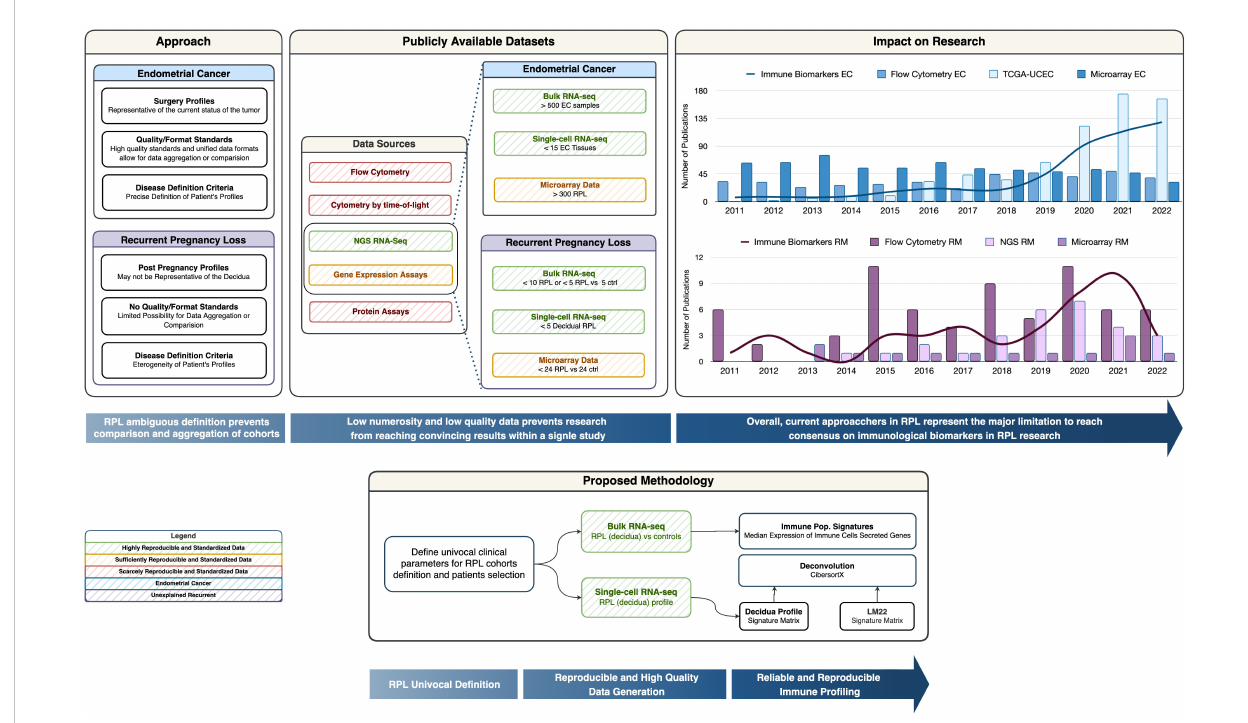
FIGURE 1 Graphical Abstract. The Approach box provides a summary of Recurrent Pregnancy Loss de fi nition pitfalls compared to Endometrial Cancer Research. The Publicly available datasets box provides insight into the reproducible and non-reproducible technologies in the immunological fi eld, along with a representation of the numerosity for the cohorts in RPL vs . EC. The Impact on Research box represents the trend of publication on PubMed with the keywords listed in the legend and we can observe how the number of publications on biomarkers is correlated with the biotechnological revolution. The Proposed methodology box represents a simpli fi ed schema of in-silico immune pro fi